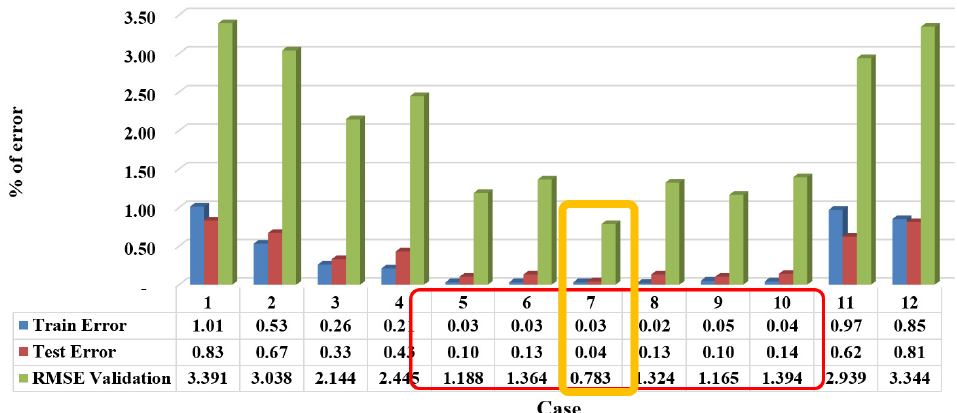
Figure 5. Error results comparison of the Soil Moisture value forecasting in different cases of learning rate (LR) and split ratio (SR)—Bi-LSTM model.